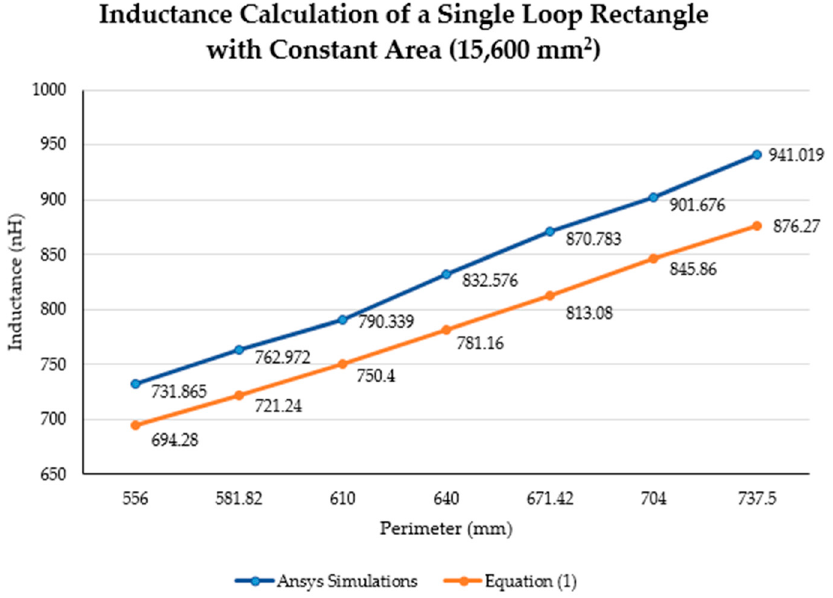
Figure 12. Theoretical and simulated inductance calculation (nH) with a constant area (15,600 mm 2 ).